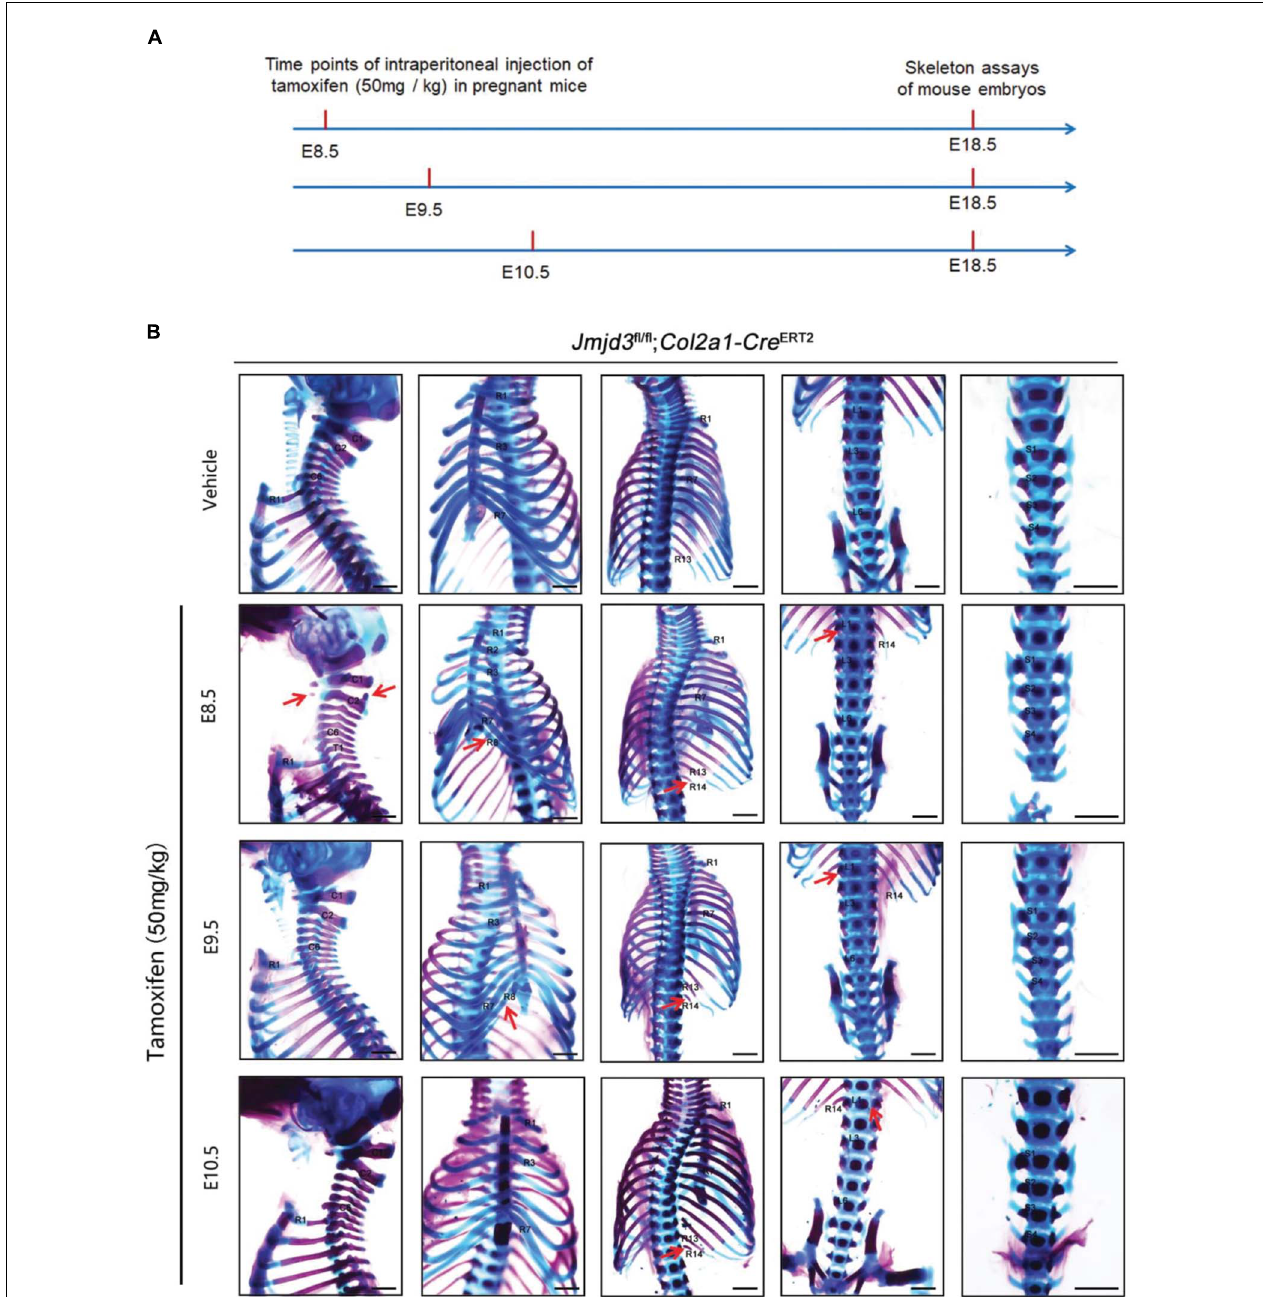
FIGURE 3 | Homeotic transformations by tamoxifen induced Jmjd3 conditional knockout in Col2a1 expressing chondrogenic cells at E8.5, E9.5, and E10.5 days. (A) Experimental design for studying the roles of Jmjd3 in chondrogenic cells on body axis patterning. (B) Skeletal phenotypes were prepared from E18.5 mouse embryos. The red arrow indicates homeotic transformations of axial skeletons. Frequencies of homeotic transformations are given in Table 1 . The cervical (C), rib (R), lumbar (L), and sacral (S) vertebrae are numbered. For schematic explanation, see Supplementary Figure 9 . Scale bar, 1 mm.